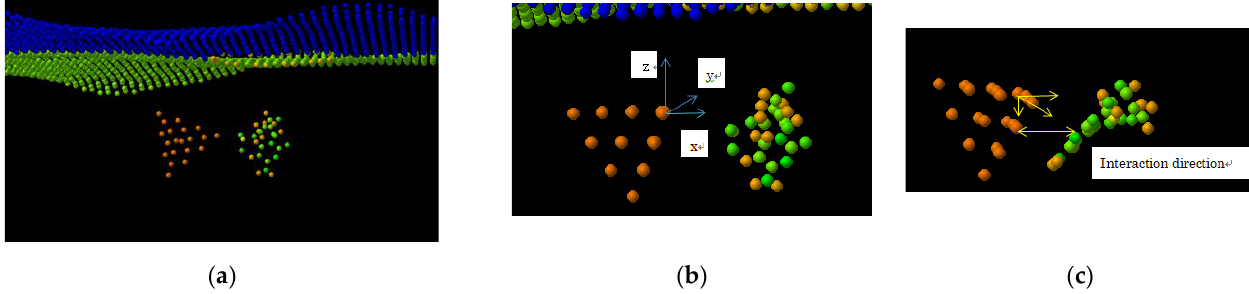
Figure 6. ( a ) System of Au 20 nanoparticle and cytosine nucleotide vs. graphene sheet in initial Au 20 NP orientation where interaction is localized primarily within the tip atom of the Au 20 pyramid; ( b ) rotated NP with the upper plane of the pyramid parallel to the graphene ( x,y ) plane and interaction with the edge atoms of the Au 20 pyramid enhanced; ( c ) interaction direction of nucleotide with NP changes during nucleotide conformation and alignment at the vibration time. Calculations were first carried out with the initial v com = 0 in x,y,z directions for cytosine and